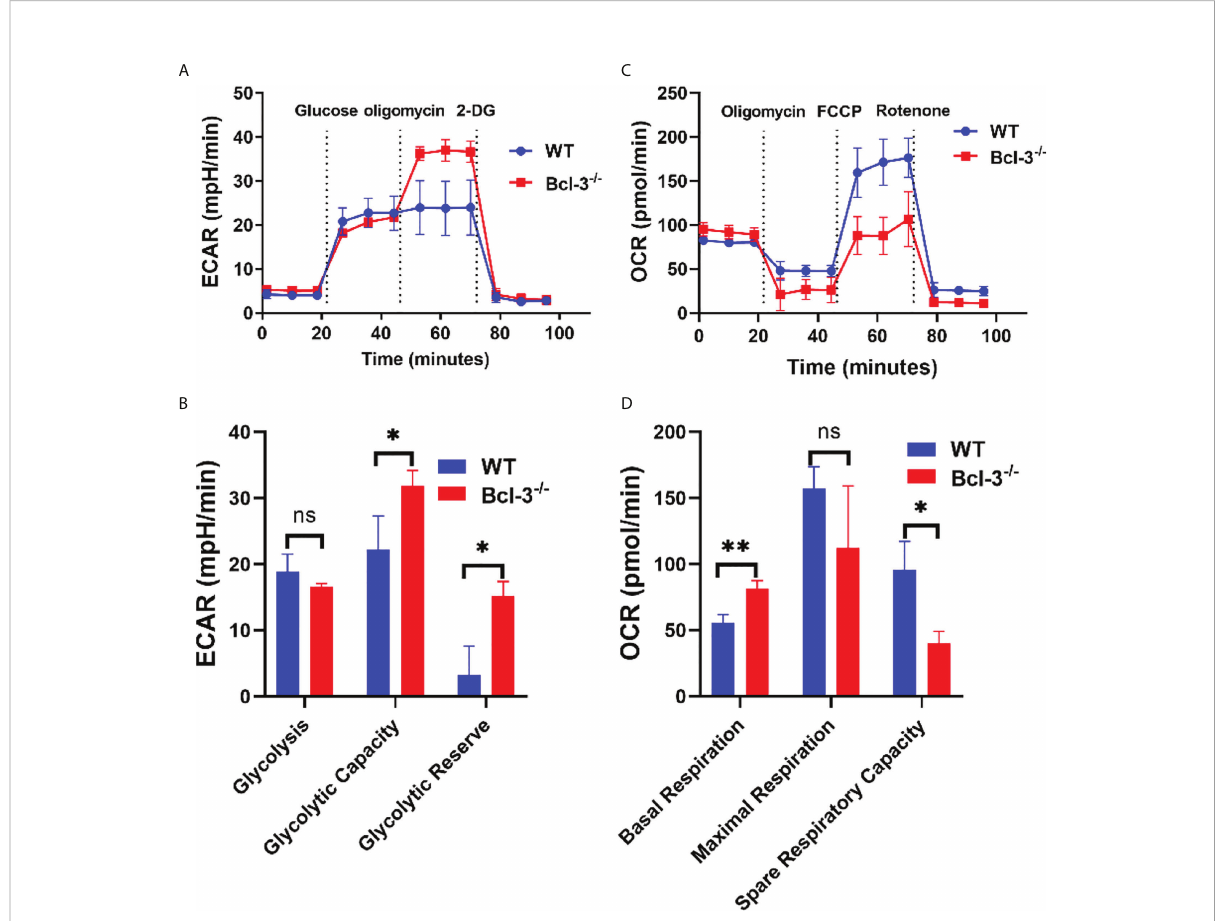
FIGURE 2 Bcl-3 depletion promotes glycolysis and inhibits mitochondrial respiration of Th17 cells. Naïve CD4 + T cells were isolated from the spleen of Bcl-3 -/- and WT mice and induced Th17 differentiation by in vitro polarization assay and detected the metabolic signals by seahorse XF24 extracellular fl ux analyzer. (A) Glycolytic pathway was detected by extracellular acidi fi cation rate (ECAR). (B) Statistical analysis of ECAR (C) mitochondrial respiration was detected by oxygen consumption rate (OCR). (D) Statistical analysis of OCR. N = 3 for each group. Data above are representative of 3 independent experiments. *P <0.05, **P